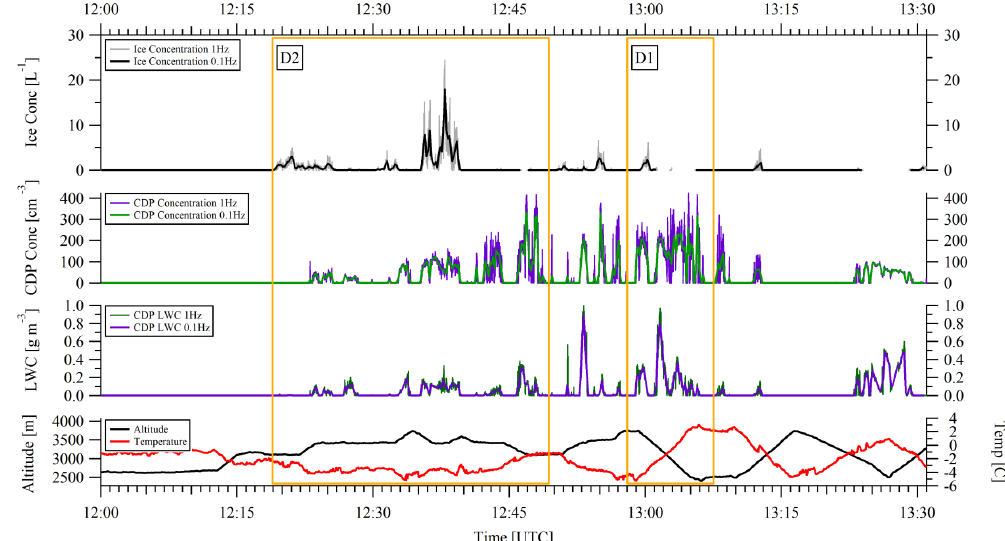
Figure 8. Microphysics time series data for summer case 2. Data includes temperature ( ◦ C) and altitude (m) (lower panel) together with 1 and 10s data sets for CDP liquid water content (gm − 3 ) , CDP concentration (cm − 3 ) (middle panels), ice water content (gm − 3 ) and ice number concentrations (L − 1 ) (top panel). Profile D1 is described in the